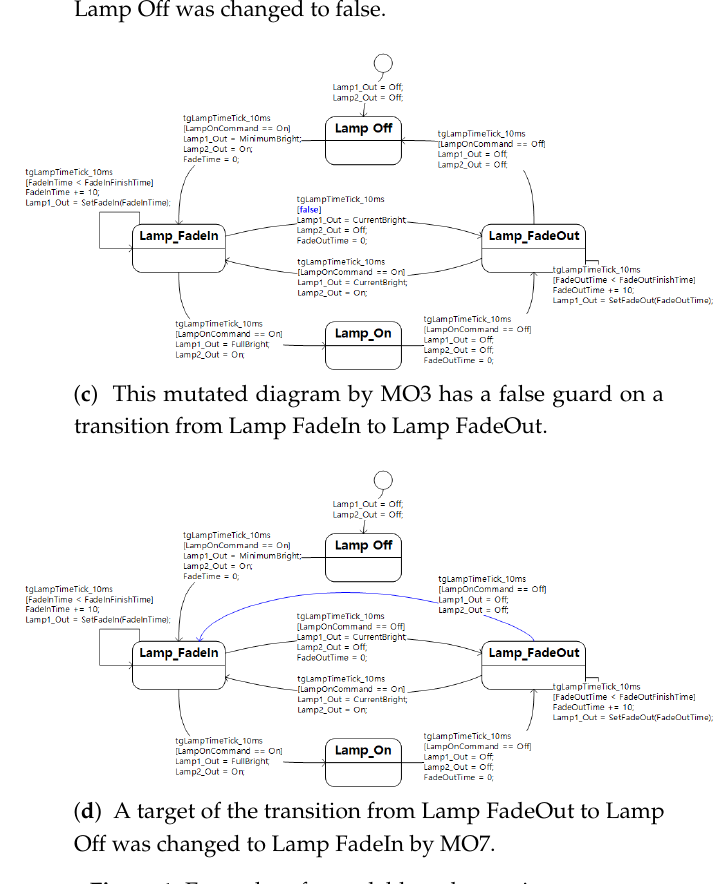
Figure 1. Examples of a model-based mutation